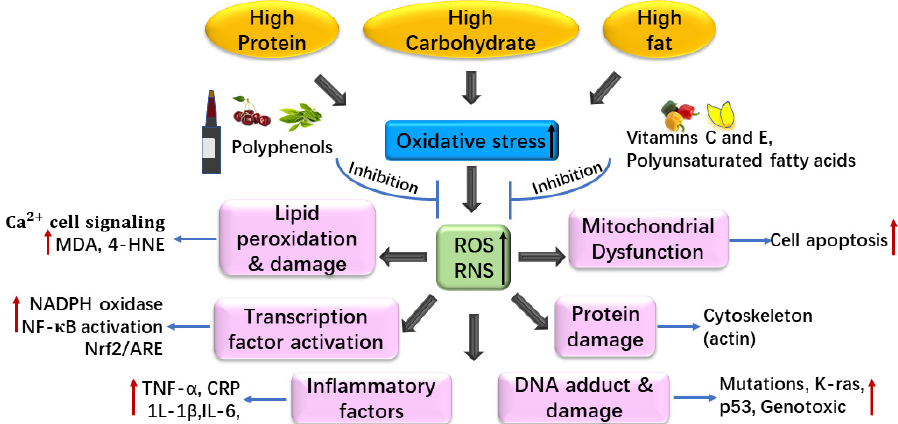
Figure 2. Associations between diet and oxidative stress. ROS, reactive oxygen species; RNS, reactive nitrogen species; MDA, malondialdehyde; 4-HNE, 4-hydroxynonenal; NADPH, triphosphopyridine nucleotide; TNF- α , tumor necrosis factor alpha; IL-6, interleukin-6; IL-1 β , interleukin-1 β ; CRP, C-reactive protein; NF- κ B, nuclear factor kappa-B; Nrf2, NF-E2-related factor 2; ARE, antioxidant response element; p53, a tumor suppressor gene; K-ras, a proto-oncogene. Omega-3 fatty acids in fish, nuts, or seed oil are anti-inflammatory by binding to G-protein coupled receptor 120 (GPR120), which activates macrophages and inhibits toll- like receptor 2 (TLR2), toll-like receptor 4 (TLR4), and TNF- α signaling [81]. In